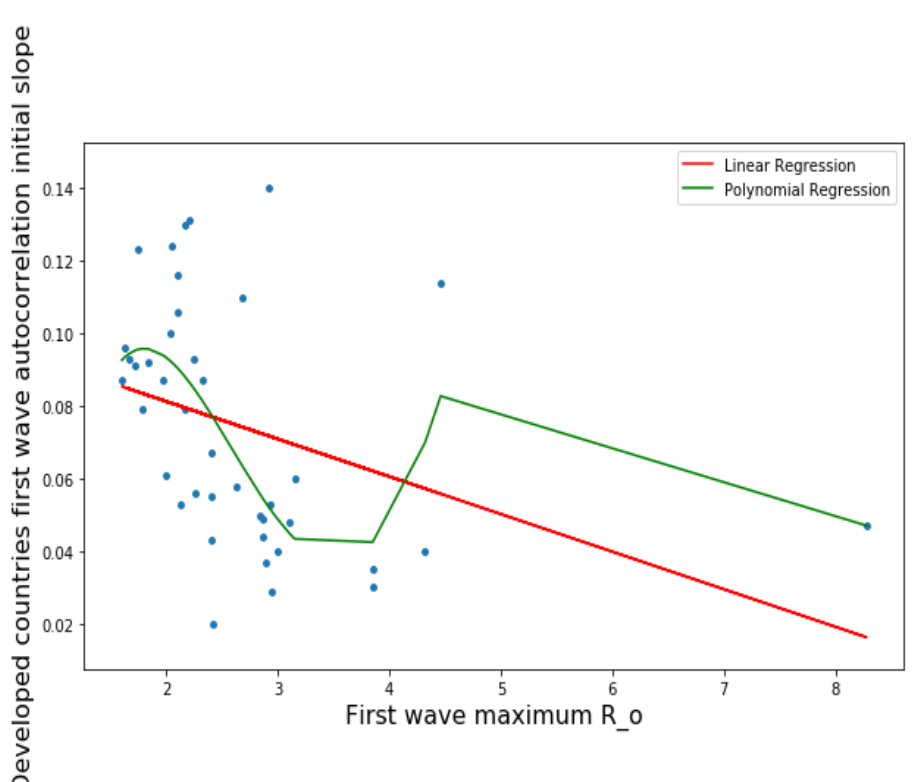
Figure 2. Linear (in red) and quartic (in green) regression plots of the opposite of the initial autocor- relation slope of the first wave vs first wave maximum R 0 for developed countries. LinregressResult slope = 0.01034, intercept = 0.1019, r value = −0.3578, p value = 0.02163, stderr = 0.00433, RMSE for linear regression = 0.0303, RMSE for polynomial regression = 0.0349, R-squared for order four poly- nomial regression = 0.33.